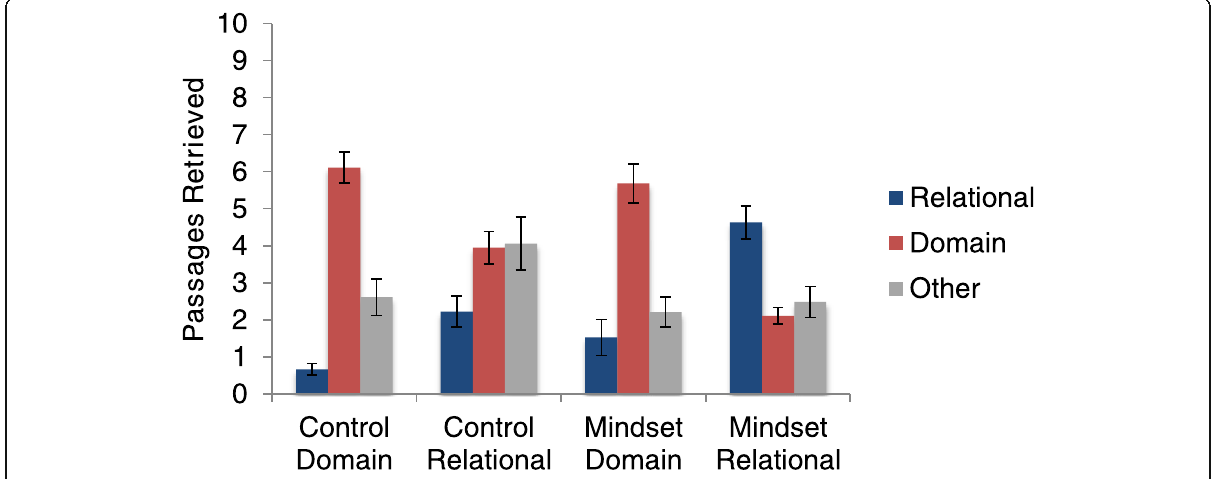
Fig. 3 Means (and standard errors) for the number of passages retrieved in experiment